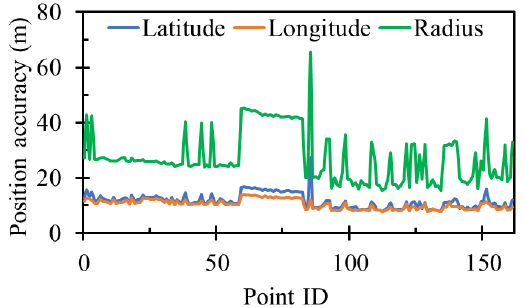
Figure 8. Geopositioning accuracy of tie points for MEX HRSC images (our method).